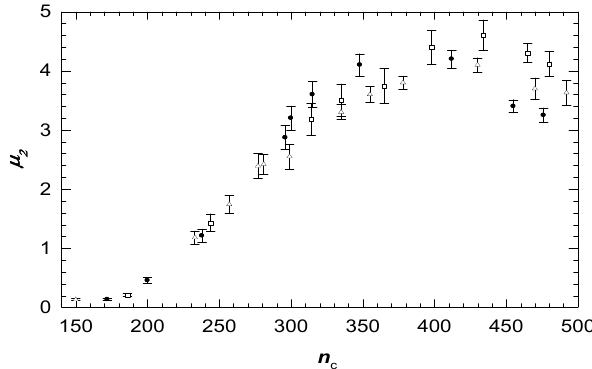
µ ff erent wet foams containing grain boundaries 2 with n c as di